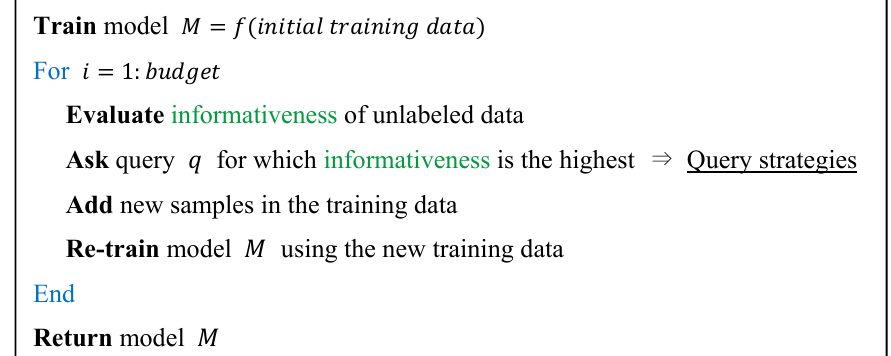
Figure 2. General active learning procedure.